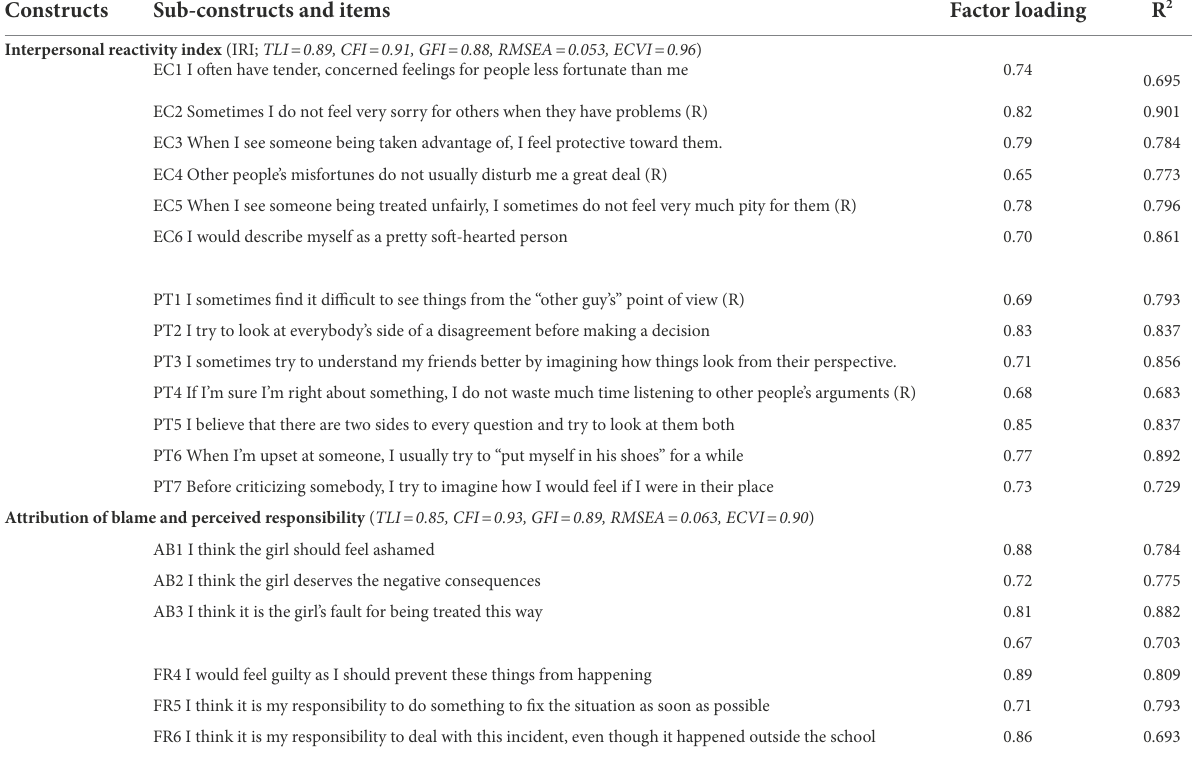
TABLE 2 Instruments validation